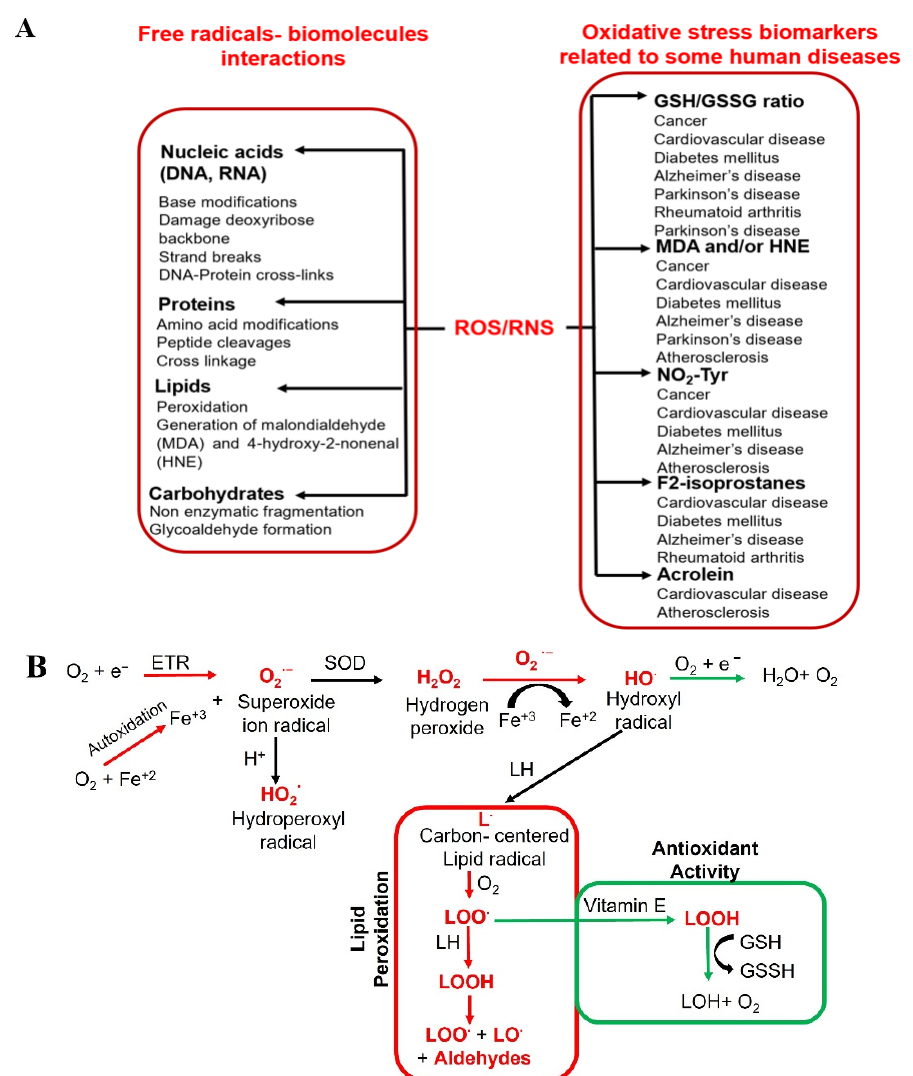
Figure 1. Schematic representation of ( A ) radicals’ impact on human health, and ( B ) the generation of various radicals in vivo .